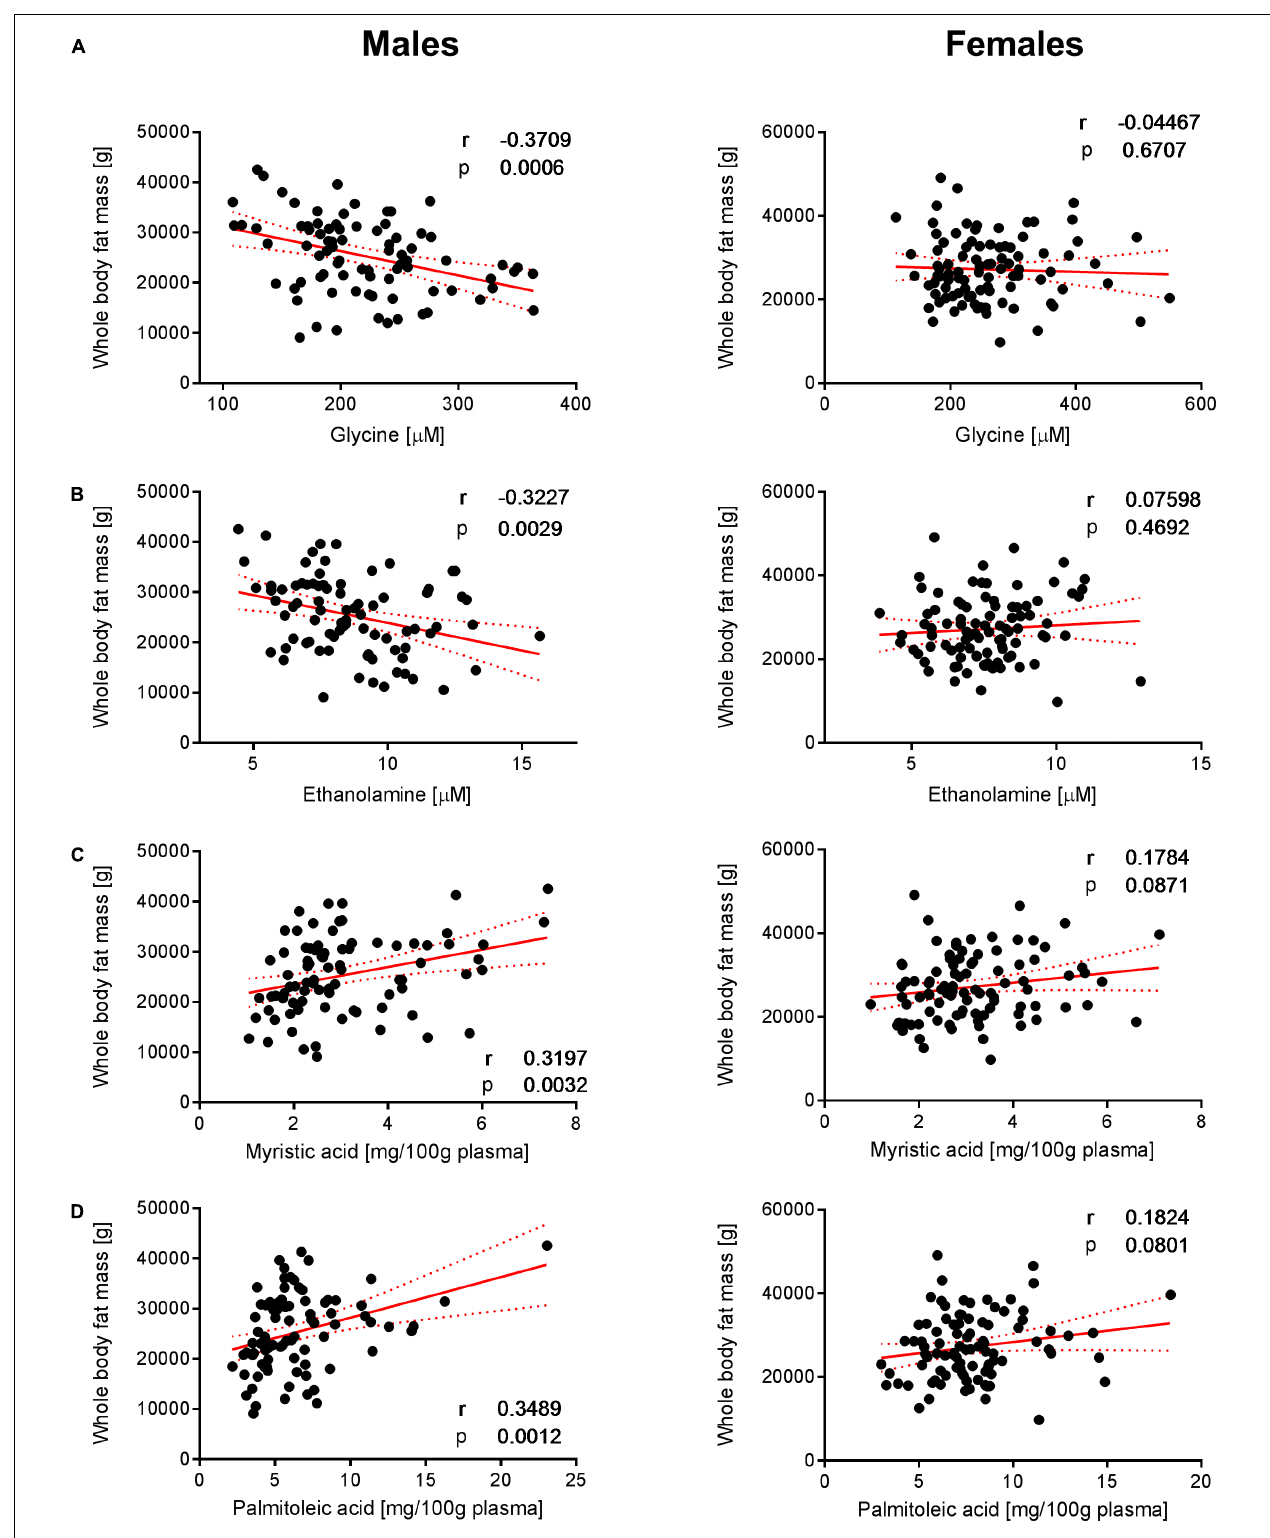
FIGURE 4 | Correlation of glycine, ethanolamine, myristic acid and palmitoleic acid with whole- body fat mass. Significant correlations of (A) glycine, (B) ethanolamine, (C) myristic acid, and (D) palmitoleic acid with whole-body fat mass were observed in males but not in females. Pearson’s correlations (r) as well as two-tailed p -values are shown. N = 83 (males) and N = 93 (females). Each dot represents an individual sample. Red dotted lines show the 95% confidence interval.